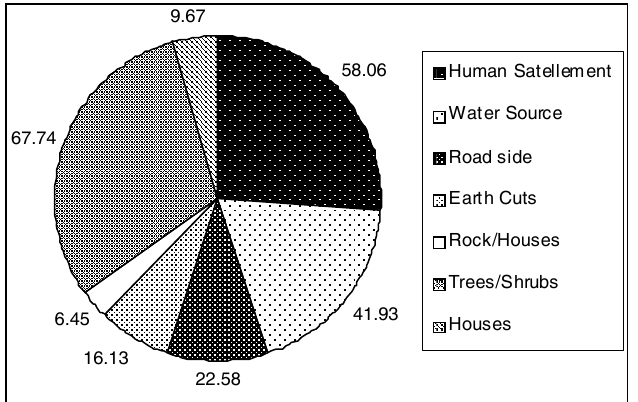
Figure 3. Proportion of nesting sites as observed among the breeding birds of Danta Forest Range, Gujarat (n=31)